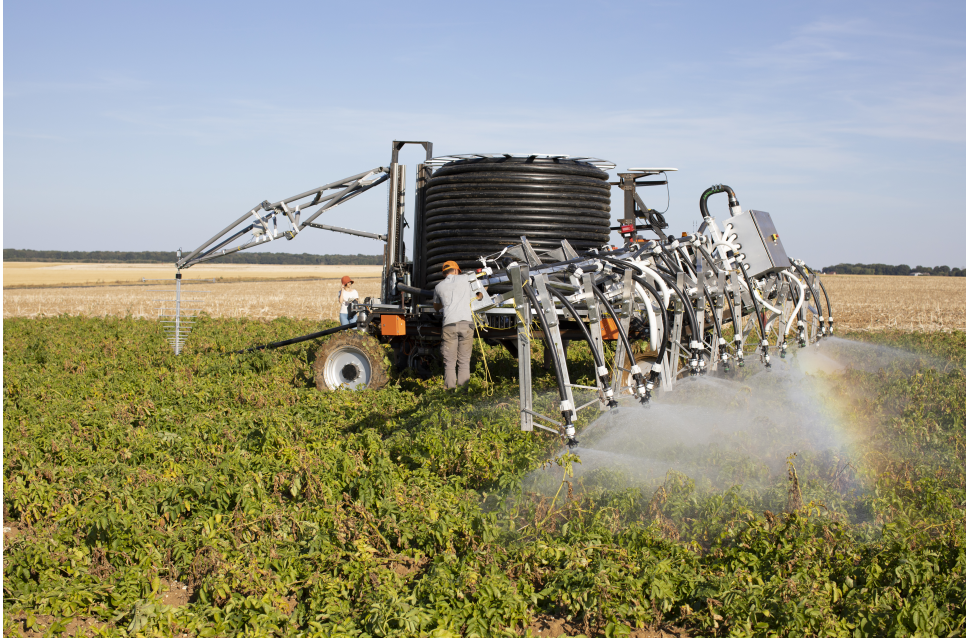
Figure 8. The radar prototype was set up on the irrigation robot Oscar (Osiris Agriculture,